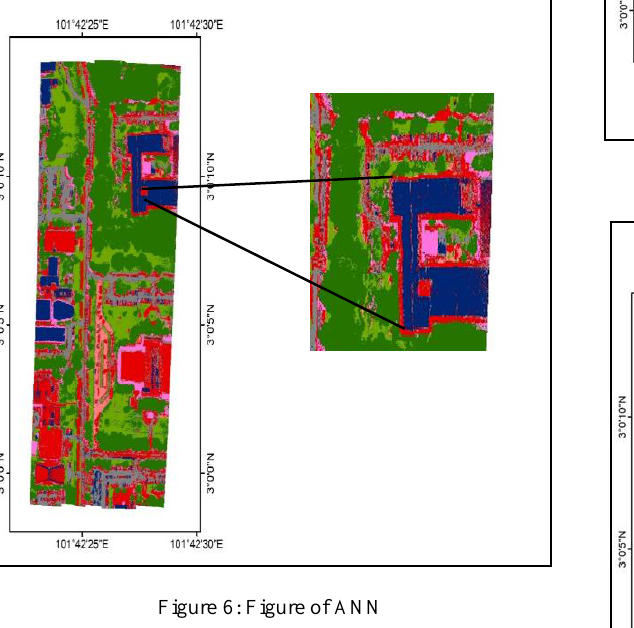
Figure 6: Figure of ANN